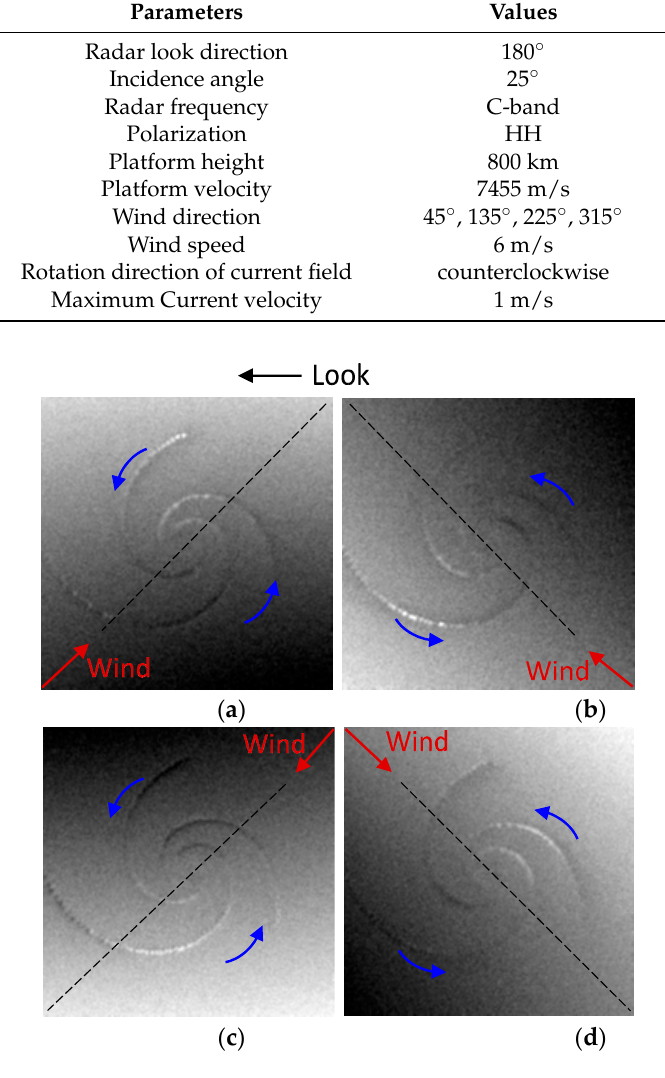
 of Figure 14a–d were calculated.   and r